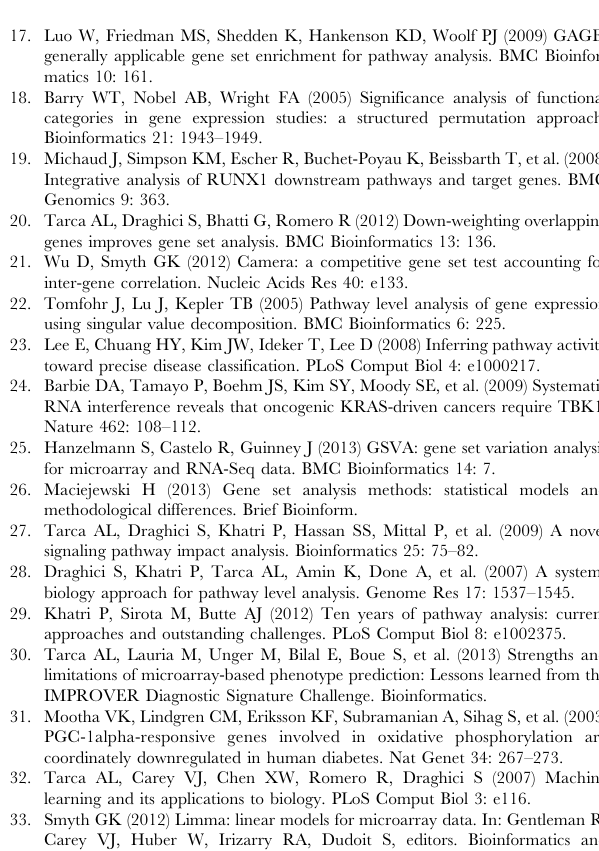
Figure S1 Distribution of significance ranks (a) and p-values (b) obtained for the target pathway in each of the 42 datasets. Table S1 The 42 datasets used to compare the 16 gene set analysis methods. Table S2 Sensitivity of the pathway analysis methods at a = 0.01 and a =